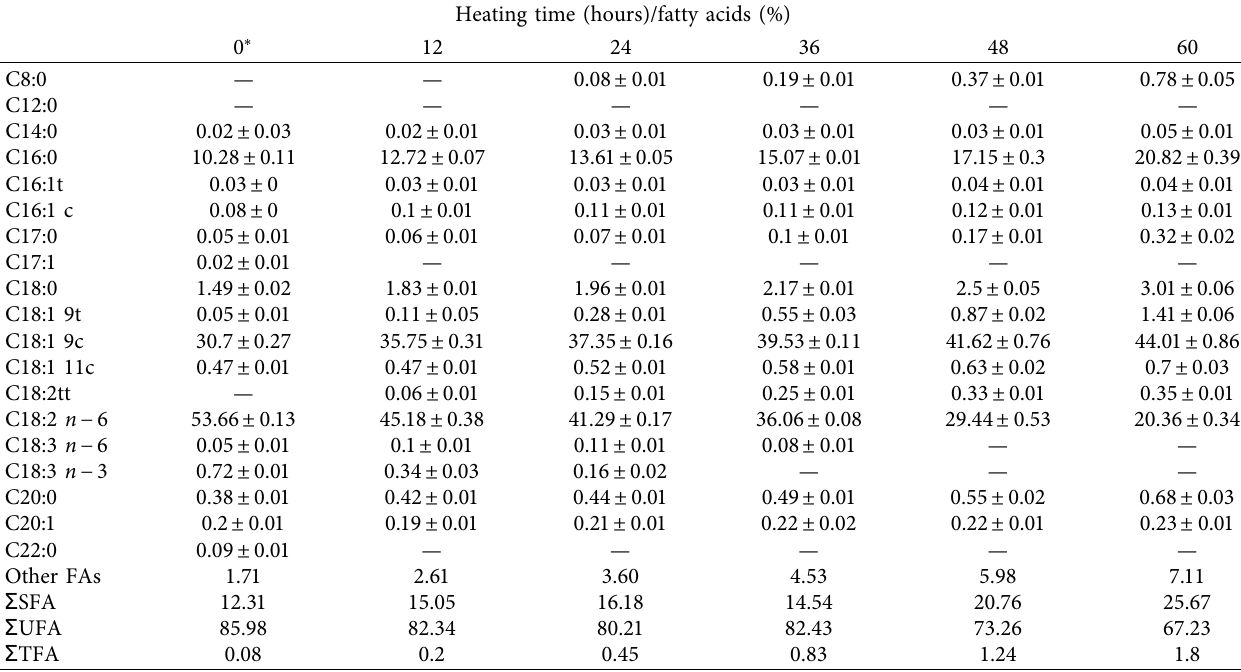
Table 12: Variation of fatty acids of corn oil under 240 ° C heating temperature at different heating